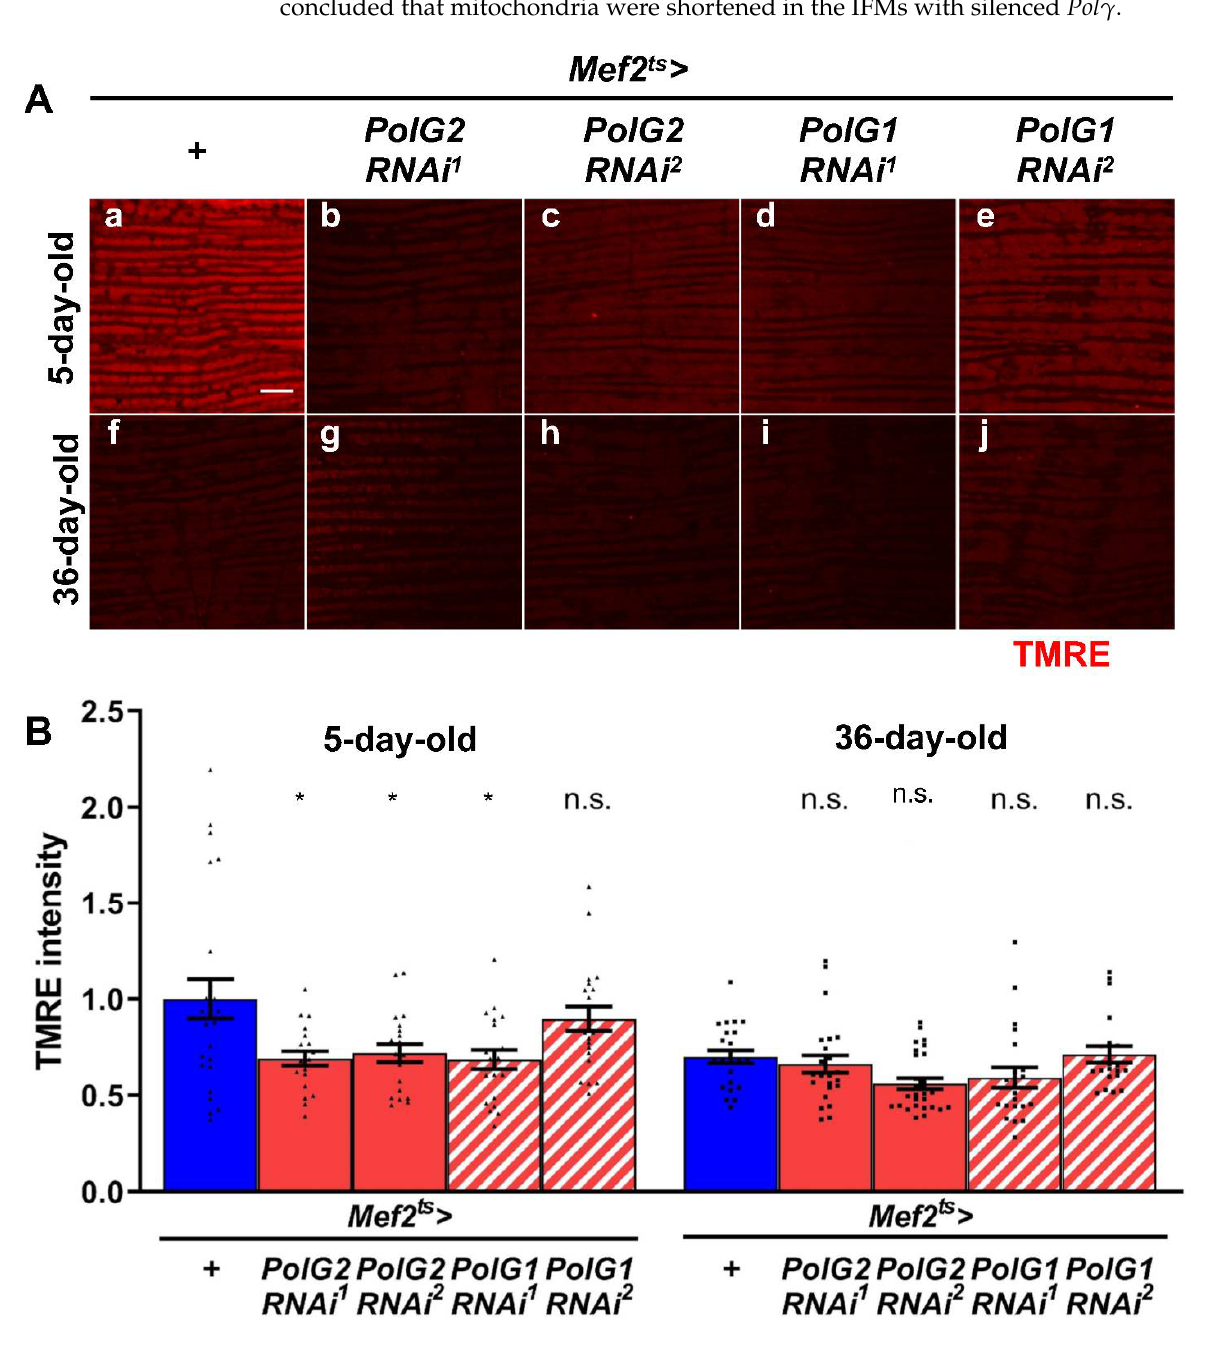
Figure 3. Measurement of mitochondrial membrane potential in the adult muscles harboring PolG1RNAi and PolG2RNAi . ( A ) Tetramethylrhodamine ethyl ester (TMRE) staining of the IFMs of 5- and 36-day-old control adults and adults harboring muscle-specific PolG2RNAi and PolG1RNAi (red). Scale bar: 10 μm. ( B ) Quantification of TMRE intensity per confocal field (4.0 × 10 −2 mm 2 ) in the IFMs of 5- and 36-day-old adult flies harboring muscle-specific polG2RNAi ( Mef2 ts > PolG2RNAi 1 ( n = 20 for 5-day-old, n = 24 for 36-day-old), Mef2 ts > PolG2RNAi 2 ( n = 20, 28) and polG1RNAi ( Mef2 ts > PolG1RNAi 1 ( n = 20, 22) and Mef2 ts > PolG1RNAi 2 ( n = 20, 20)), normalized to the control adults at the same age ( Mef2 ts > + ( n = 25, 24)). (* p < 0.05, n.s.; not significant, one-way ANOVA with Bonferroni’s multiple comparisons test).